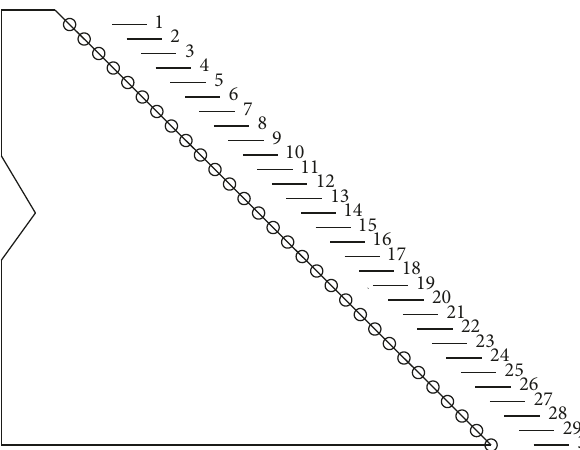
Figure 12: Sampling point of the moisture